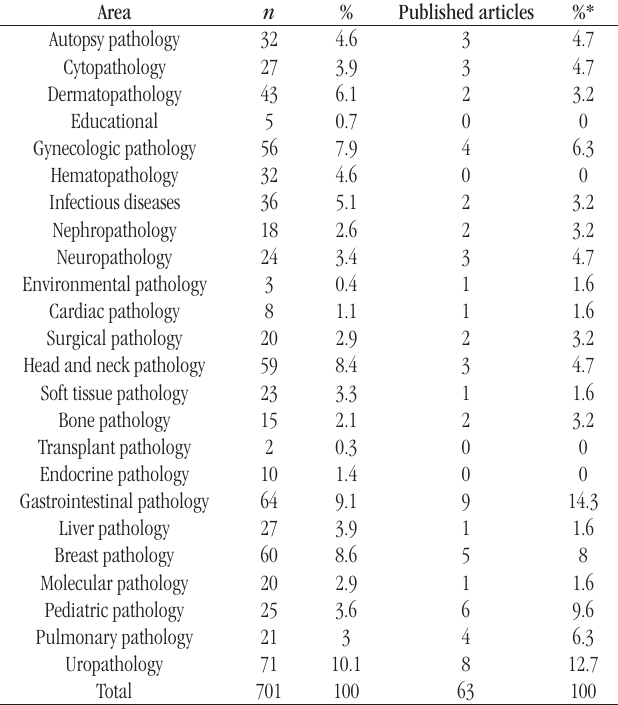
taBLE 4 − Relationship between absolute and relative values of the papers presented as abstracts and articles published, for pathology areas in the studied meetings